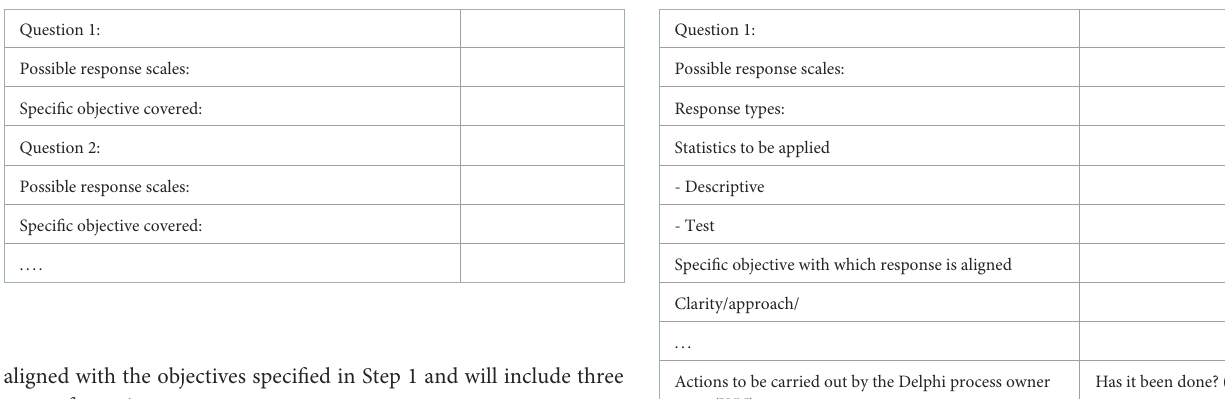
TABLE 3 Draft questionnaire. TABLE 4 Review of the draft